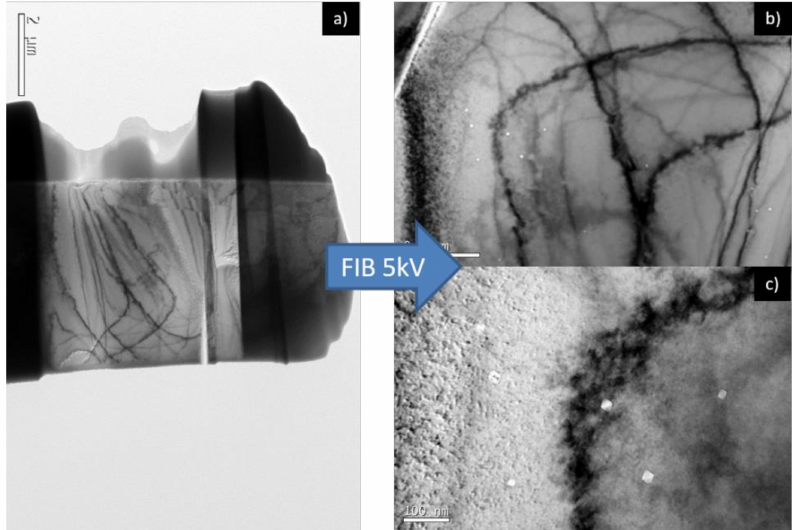
Figure 11. ( a ) Lamella overview irradiated at 300 ◦ C up to 4.27 × 10 15 cm − 2 ; and ( b , c ) cavities observed in the same